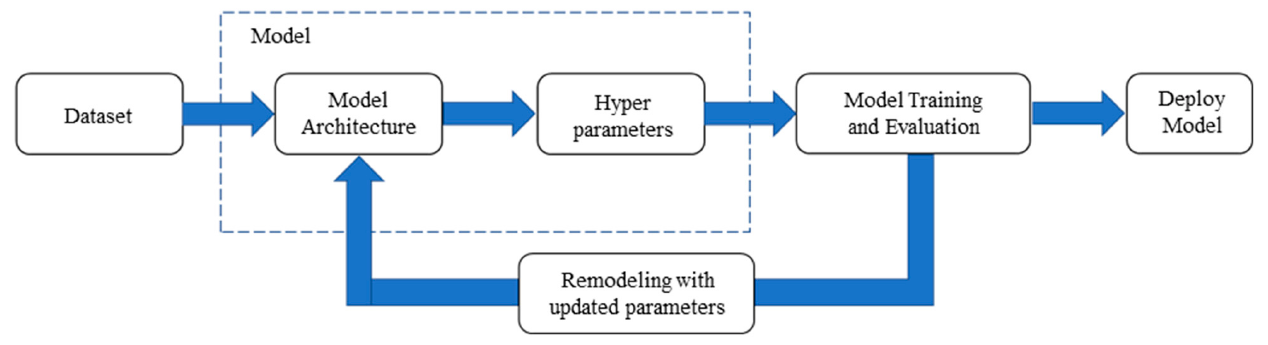
Figure 4. Training steps involved in ML.